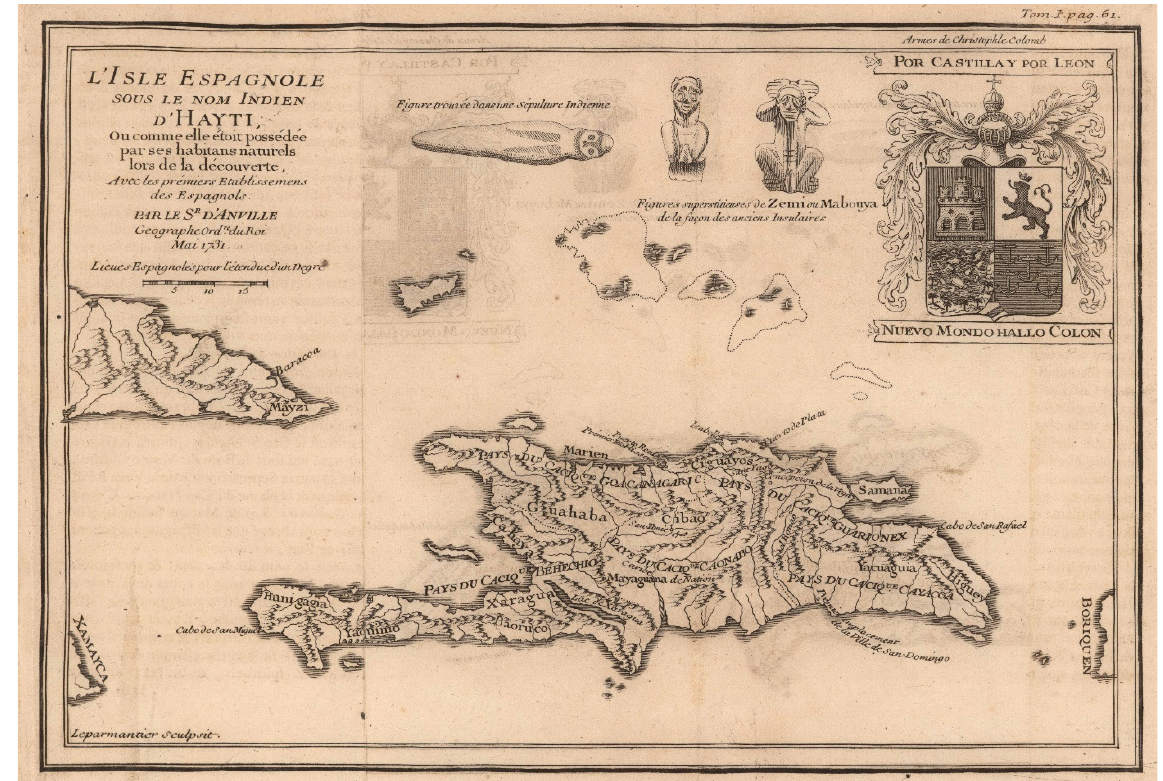
Figure 9. Map of Haytí showing the supposed indigenous territories by Pierre-Francois-Xavier de Charlevoix in 1731 (courtesy of the digital collection of John Carter Brown Library at Brown University).